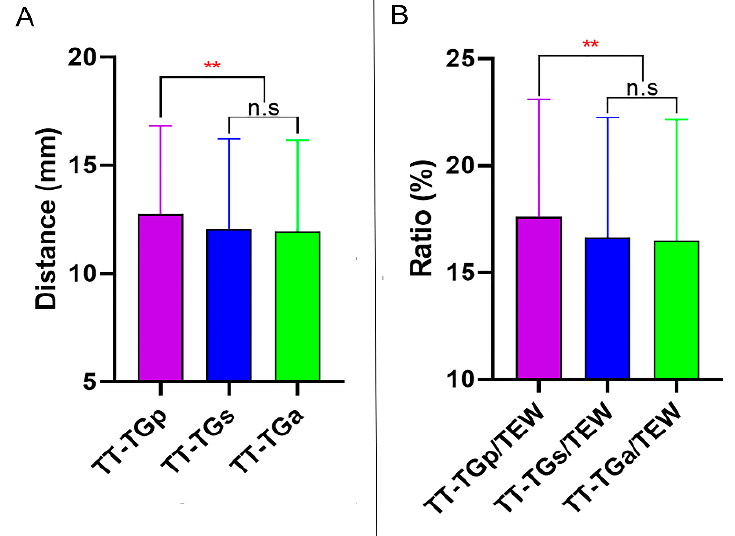
Figure 4. ( A ), Difference among the TT-TG distances in the study group. ( B ) Difference among the TT-TG distances/TEW in the study group. TT-TG distance, tibial tubercle-trochlear groove distance. TEW, surgical transepicondylar width. n.s, none statistically significant. ** Statistically significant with p < 0.001.